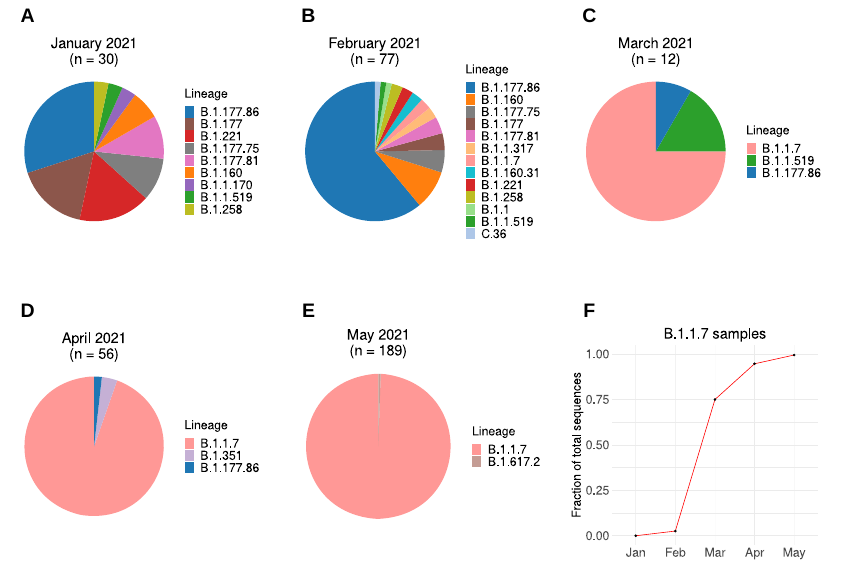
Figure 1: Detection of different SARS-CoV-2 lineages by WGS.